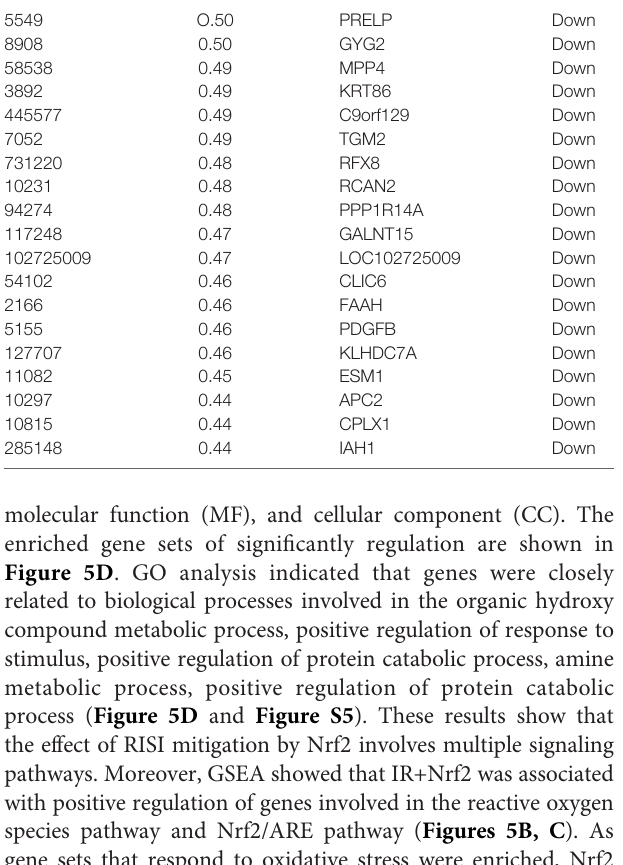
TABLE 2 | Downregulated genes between Ad-NC+20 Gy radiation and Ad-Nrf2+20 Gy radiation.